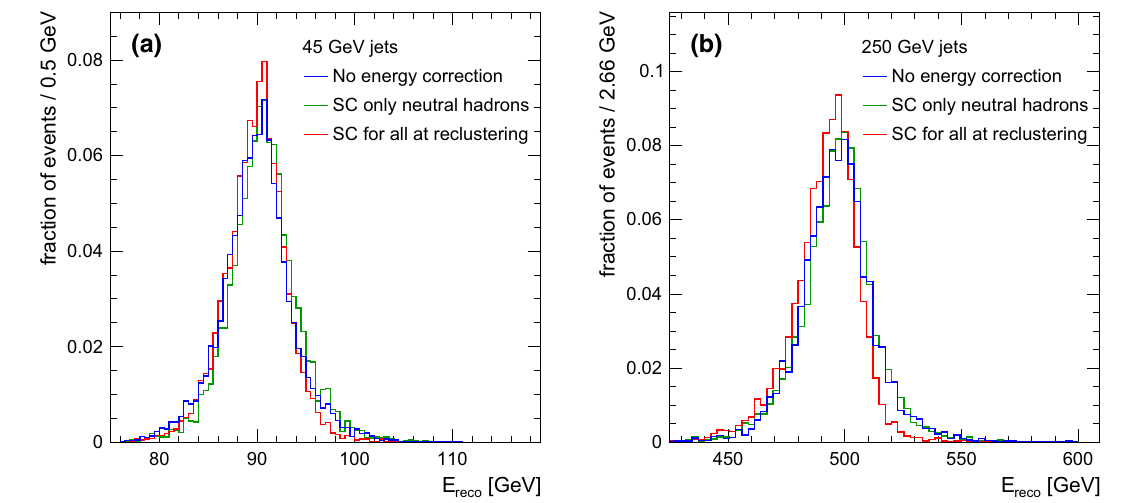
Fig. 7 Normalised distribution of the energy sum per event for two different jet energies: a 45 GeV and b 250 GeV, for all three scenarios of energy correction studied here